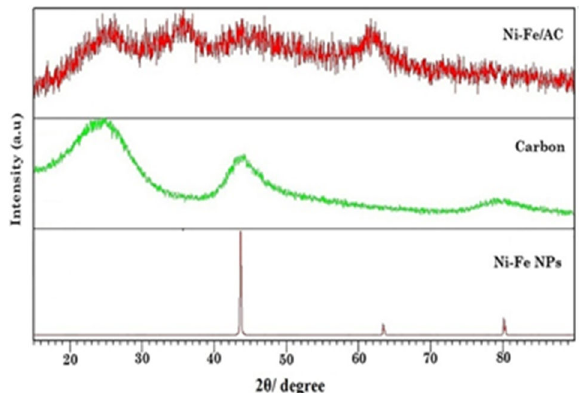
Fig. 4. XRD spectra of nanoscale Ni/Fe particles on AC